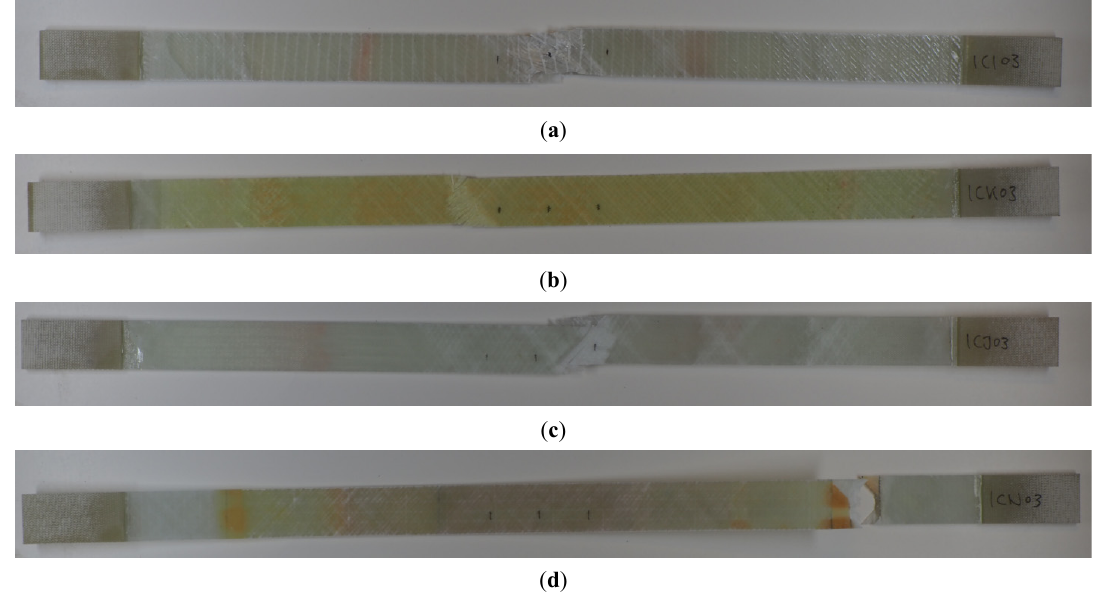
Figure 7. Locations of failure for some samples: ( a – c ) UV1, V1, and V2 samples (failure in the middle of the sample), and ( d ) UV2 sample (failure at the border scarf/parent laminate).